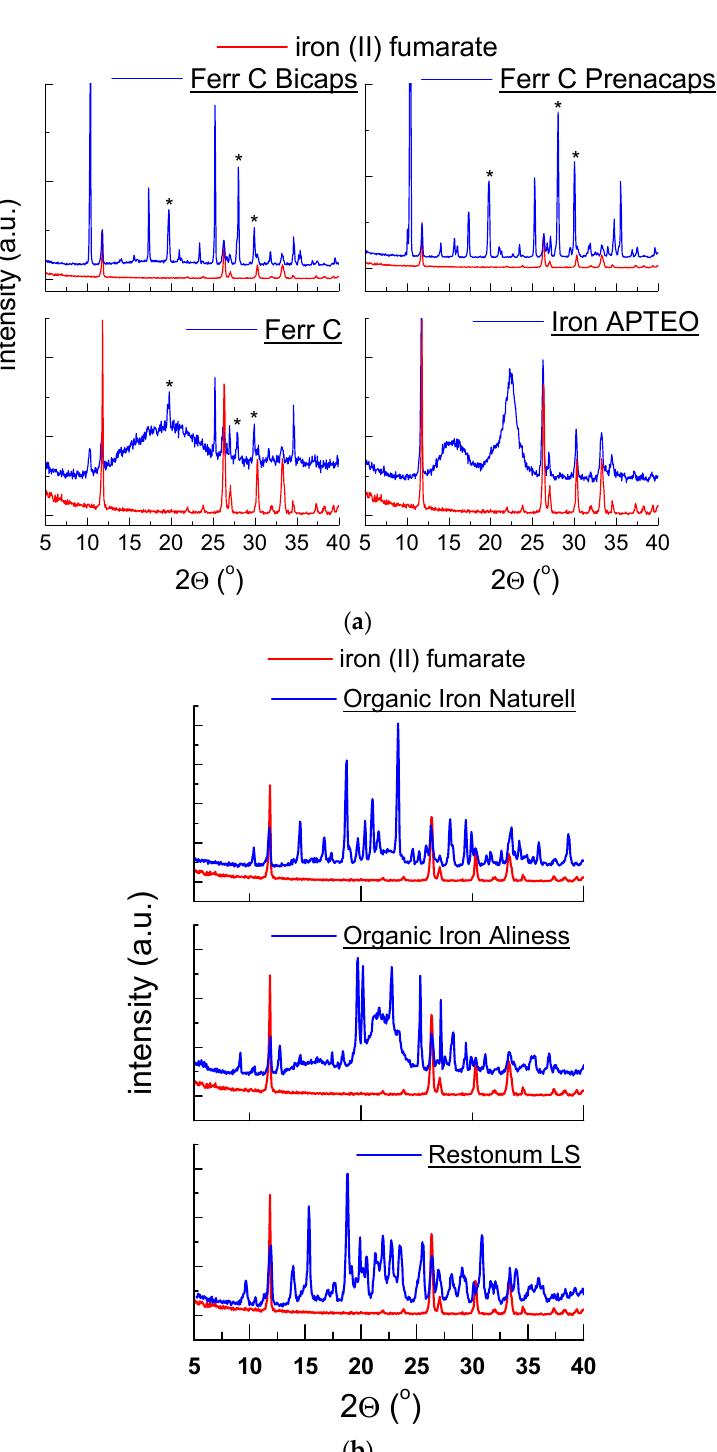
Figure 4. Diffraction patterns for dietary supplements: ( a ) Ferr C Bicaps , Ferr C Prenacaps , Ferr C , Iron APTEO , ( b ) Restonum LS , Organic Iron Naturell , Organic Iron Aliness , *—vitamin C.